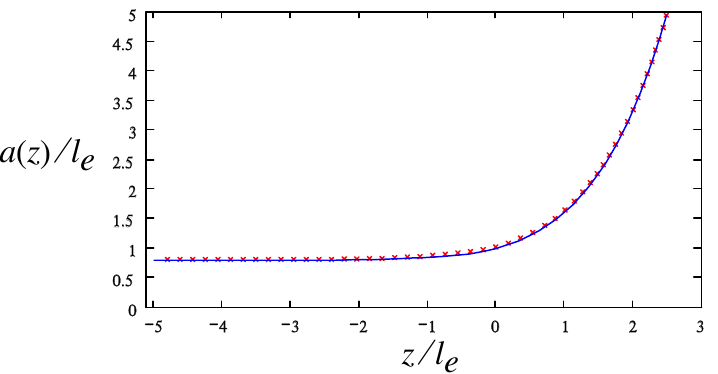
Figure 8. The dependence a ( z ) / l e vs. z / l e in the transition zone: our data (crosses), the similarity solution for the bead-string structure obtained using a neo-Hookean elastic model [12] (solid line); l e = 2 1/3 a 0 is the elasto-capillary